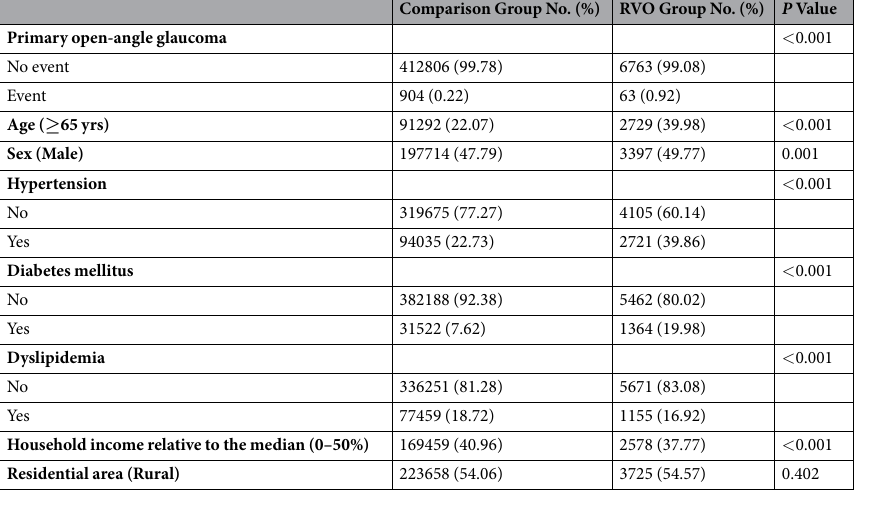
Table 1. Characteristics of the study population comparison group without retinal vein occlusion (RVO; n = 413710) and retinal vein occlusion group (n = 6826). RVO = retinal vein